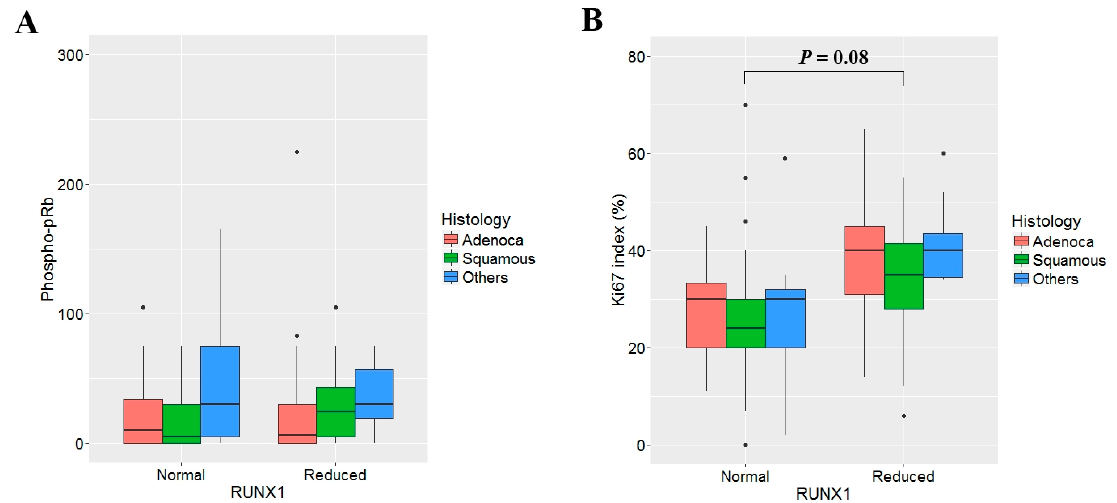
Figure 5. The e ff ect of RUNX1 expression on phospho-pRb (Ser-807 / 811) level and Ki-67 proliferation Figure 5. The effect of RUNX1 expression on phospho-pRb (Ser-807/811) level and Ki-67 index. The expression levels of phosphorylated pRb stained using polyclonal anti-phospho-pRb proliferation index. The expression levels of phosphorylated pRb stained using polyclonal (Ser-807 / 811) antibody (Cell Signaling, Danvers, MA, USA) ( A ) and Ki-67 proliferation index ( B ) were anti-phospho-pRb (Ser-807/811) antibody (Cell Signaling, Danvers, MA, USA) ( A ) and Ki-67 compared according to the expression status of RUNX1 using Student t -test. The phospho-pRb levels proliferation index ( B ) were compared according to the expression status of RUNX1 using Student and Ki-67 proliferation index were not significantly di ff erent between tumor tissues with normal or t -test. The phospho-pRb levels and Ki-67 proliferation index were not significantly different between reduced RUNX1 expression irrespective of histologic tumor tissues with normal or reduced RUNX1 expression irrespective of histologic subgroup.